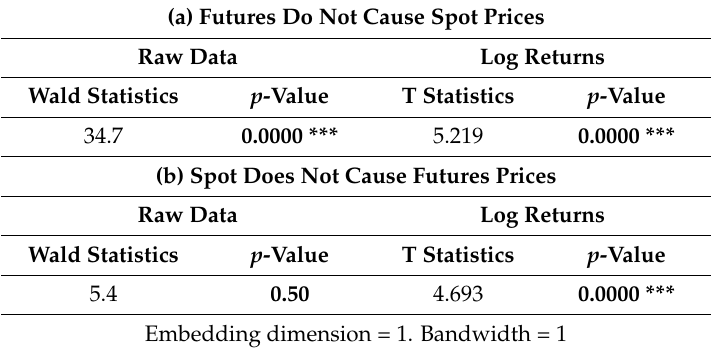
Table 5. Non-linear Granger causality test between futures prices obtained as the longest maturity on that day and spot